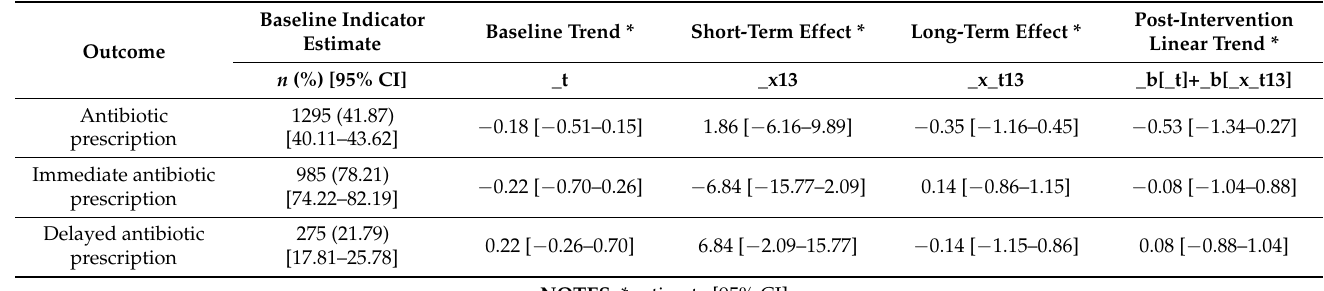
Table 3. Evaluation of the change in antibiotic prescription overall, for immediate use and delayed use, using interrupted time series analysis.